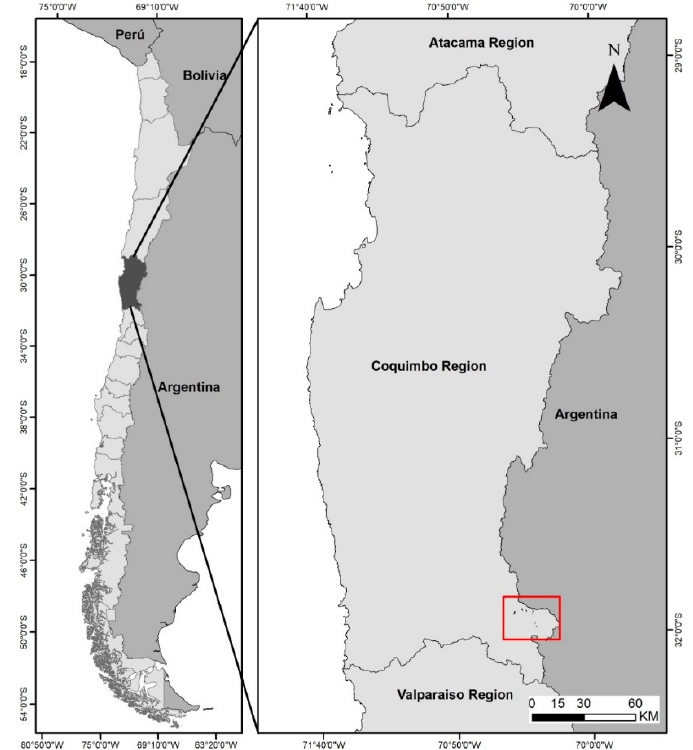
Figure 1. Location of the area where the study was carried out.